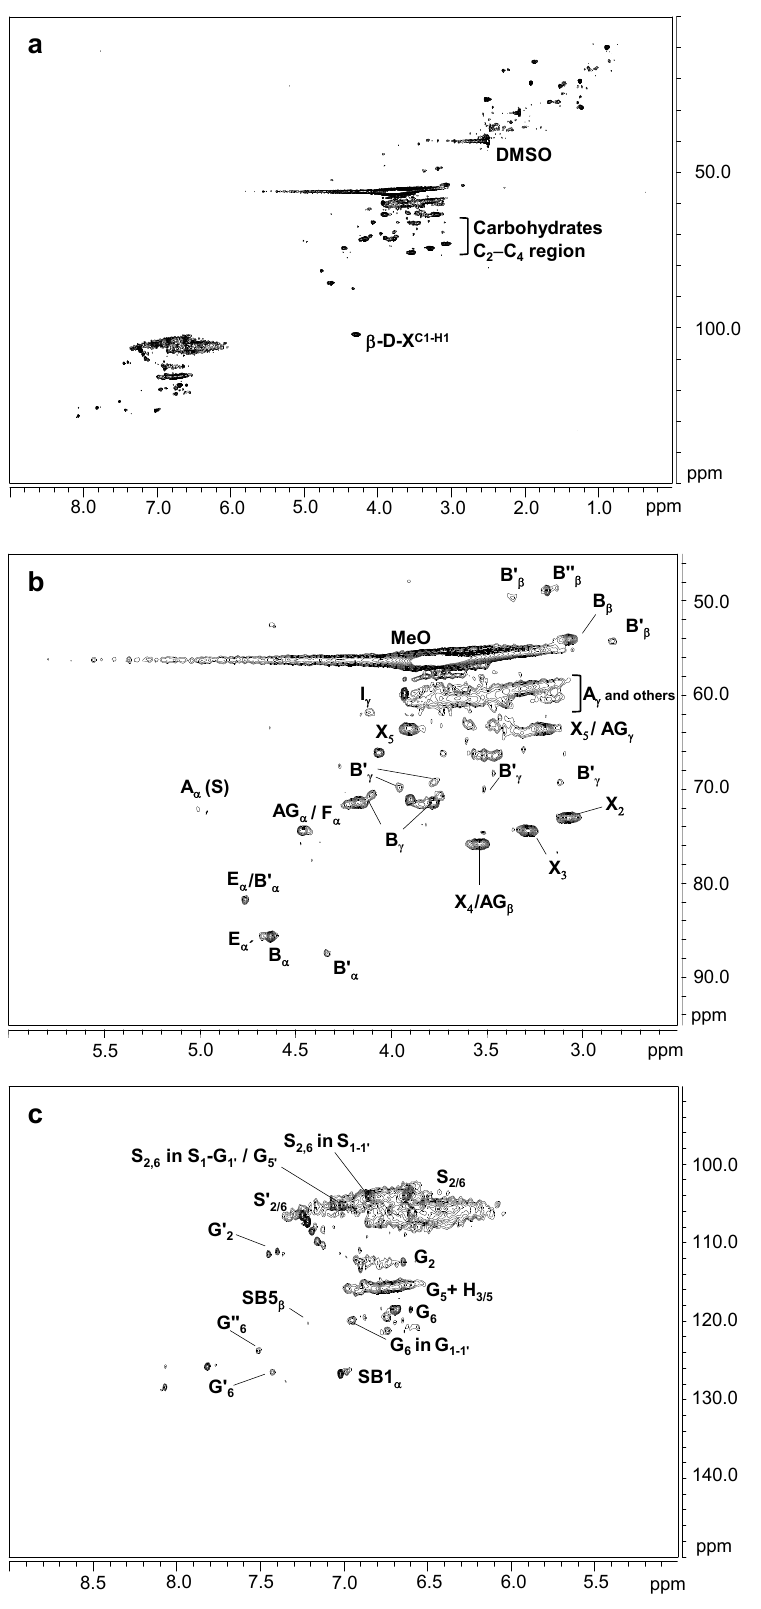
Figure 1. HSQC 2D-NMR spectra of untreated Kraft lignin. ( a ) whole spectrum, δ C / δ H 0.0–150.0/0.0–9.0; ( b ) aliphatic oxygenated region, δ C / δ H 45.0–95.0/2.5–6.0 ppm; ( c ) aromatic region, δ C / δ H 90.0–150.0/5.0–9.0 ppm .